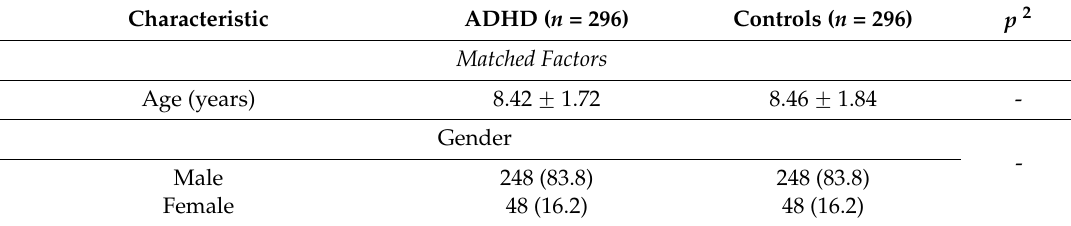
Table 1. Demographic and distribution of the risk factors of ADHD and controls 1